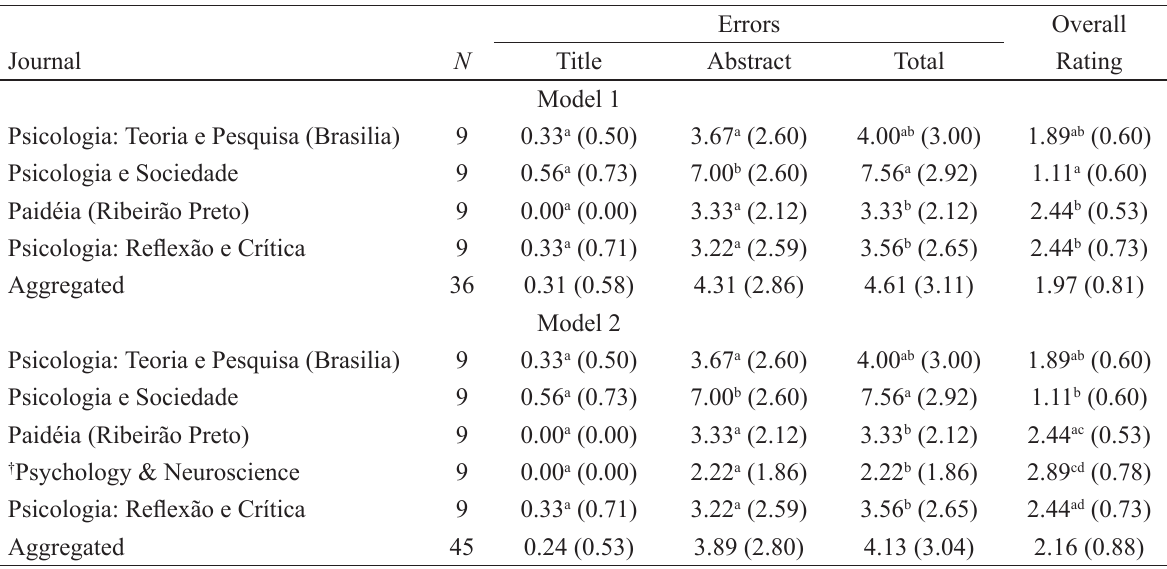
Mean (and Standard Deviation) for Error and Overall Rating Variables: Across Journals